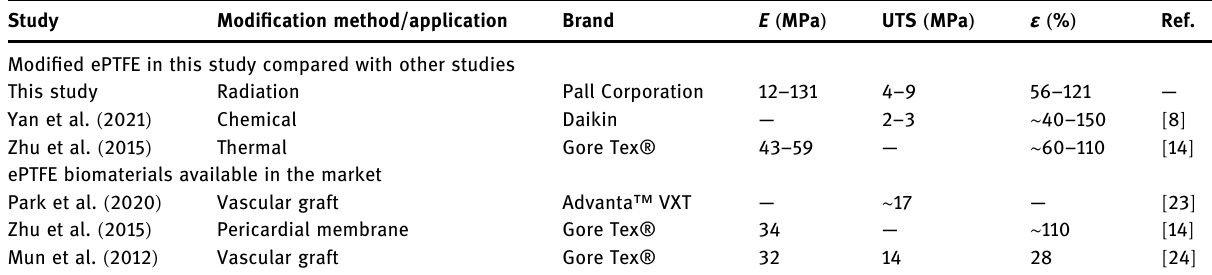
Table 2: Comparison of modi fi ed ePTFE in this study with previous study and ePTFE available in the market